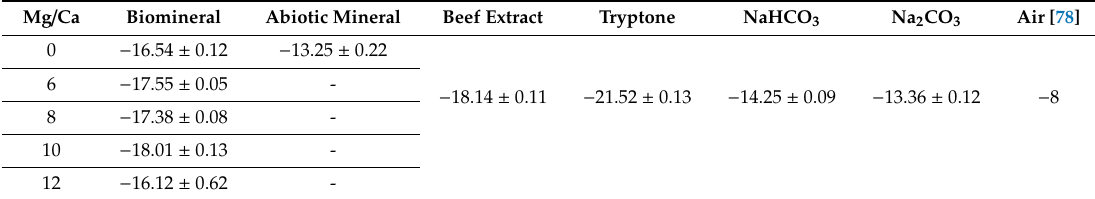
Table 1. δ 13 C PDB (% (cid:24) ) values for minerals and organic compounds in the experimental